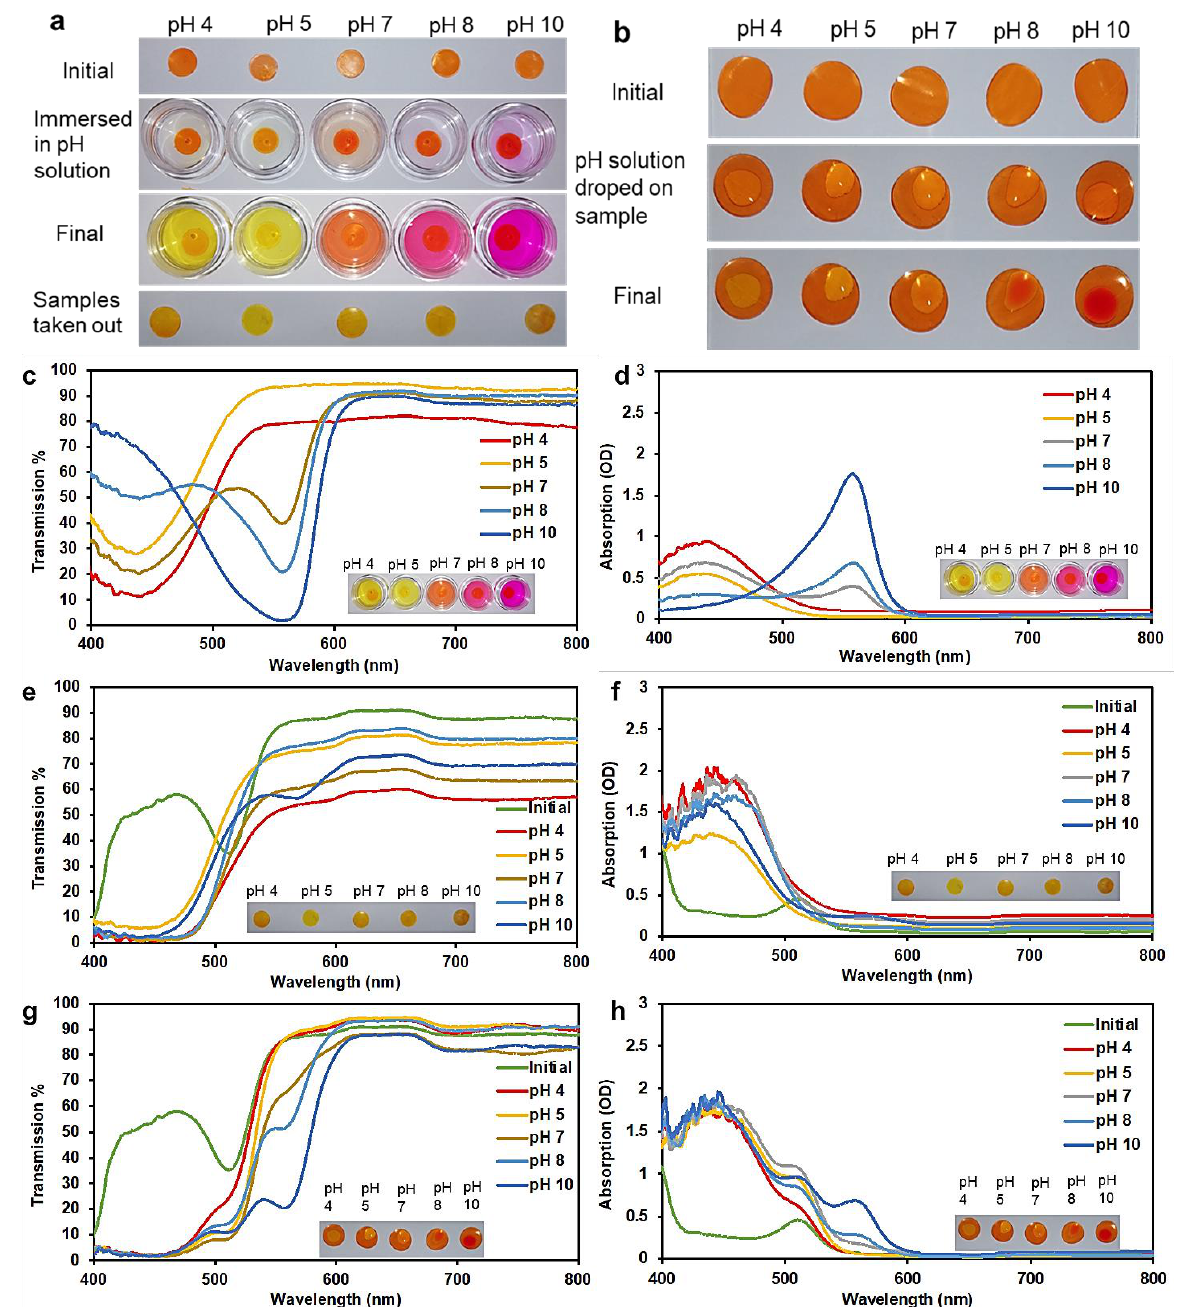
Figure 3. ( a ) The 3D printed hydrogels tested by immersion in buffer solutions of different pH. ( b ) The 3D printed hydrogels tested by dropping the pH solution onto the sample. ( c ) Optical transmission and ( d ) absorption from pH buffer solutions after hydrogel samples were immersed in them. ( e ) Optical transmission and ( f ) absorption from the hydrogel samples taken out after immersing in pH solutions. ( g ) Optical transmission and ( h ) absorption from hydrogel samples with the pH solution dropped on surface of dry 3D printed hydrogel.